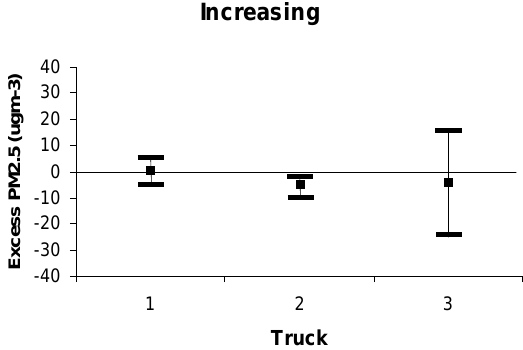
Figure 8. Ensemble average Daysmoke minus observed PM for the three days when smoke concentrations increased with distance. The spreads of the departures are shown by the horizontal bars.